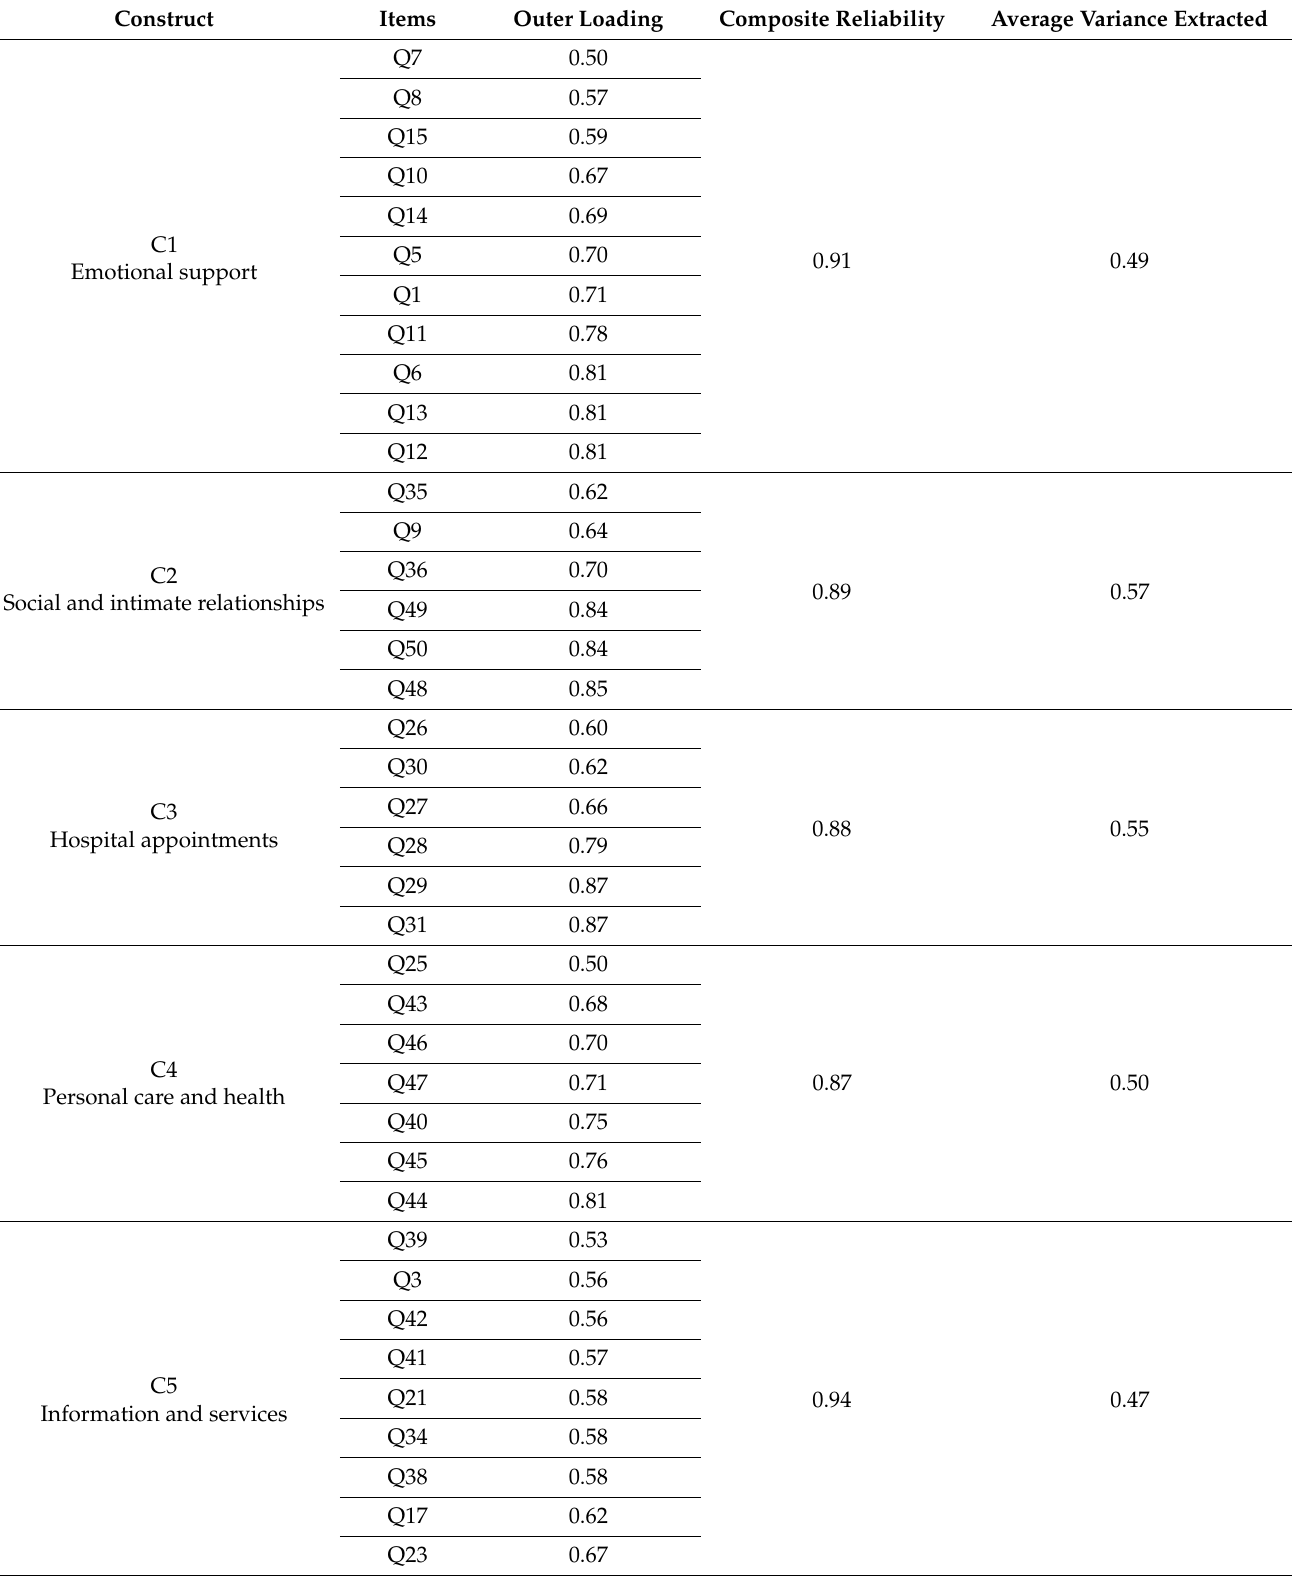
Table 5. Confirmatory factor analysis of the needs assessment tool for breast cancer (NeAT-BC) using PLS-SEM